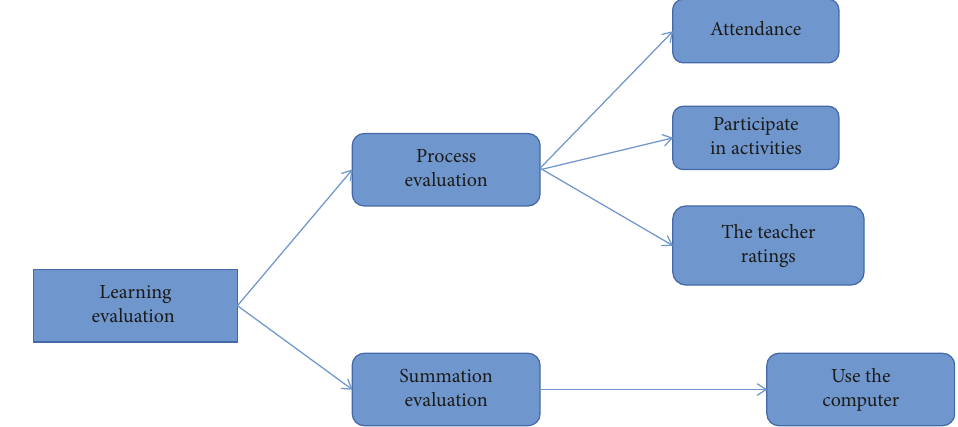
Figure 6: Learning evaluation